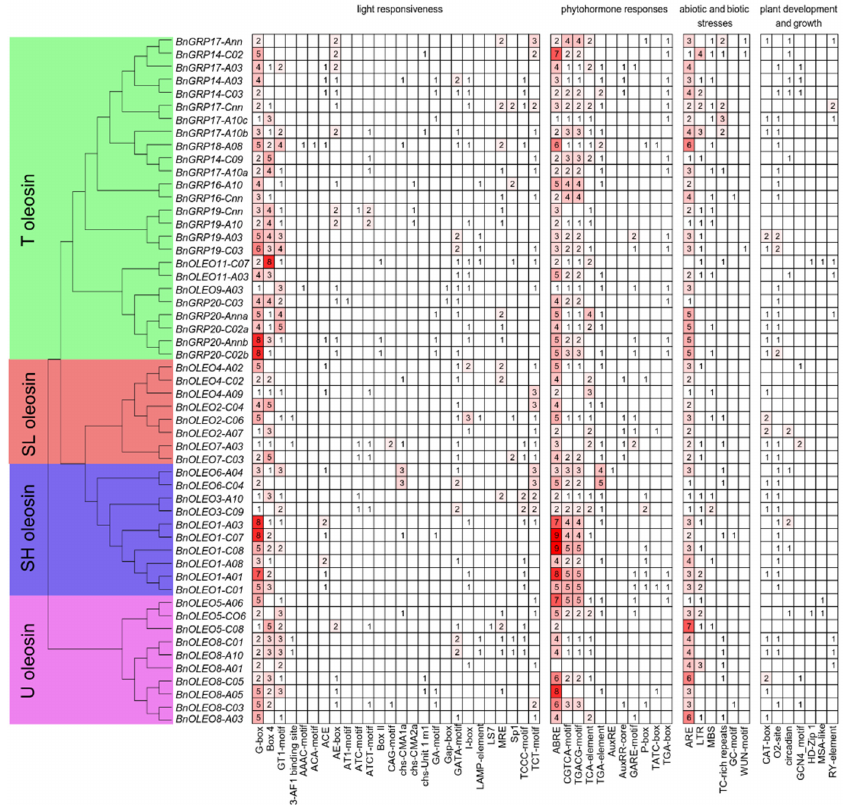
Figure 1. Analysis of cis-elements in the promoter regions of oleosin genes. The presence of different cis-acting elements was determined by the PlantCARE database.